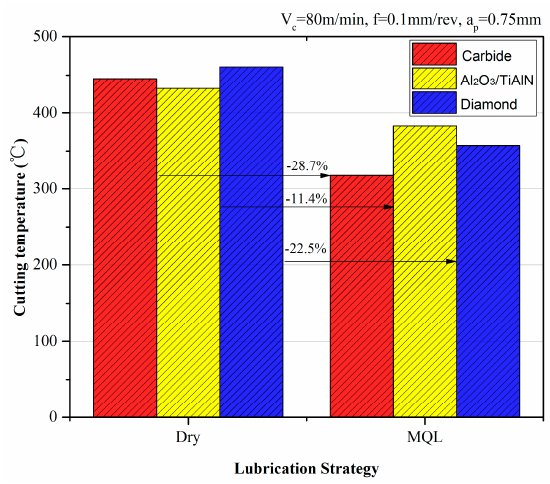
Figure 5. Cutting temperature comparison under dry and MQL conditions.